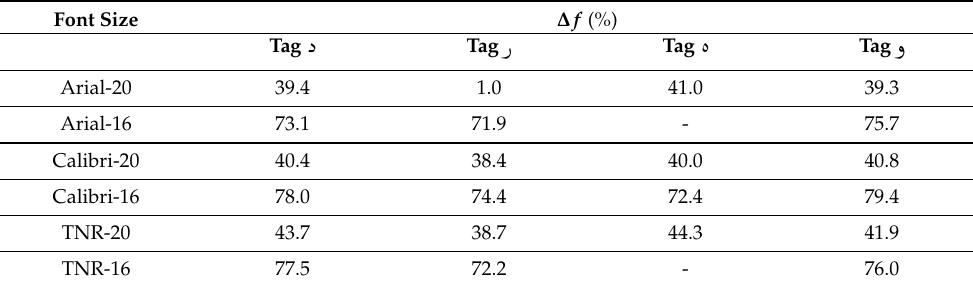
Table 11. Change in resonance frequency ( ∆ f ) in % in vertical polarization for analyzed tags for the changing font size with reference to Arial-28, Calibri-28, and Times New Roman (TNR)-28 tags. Font